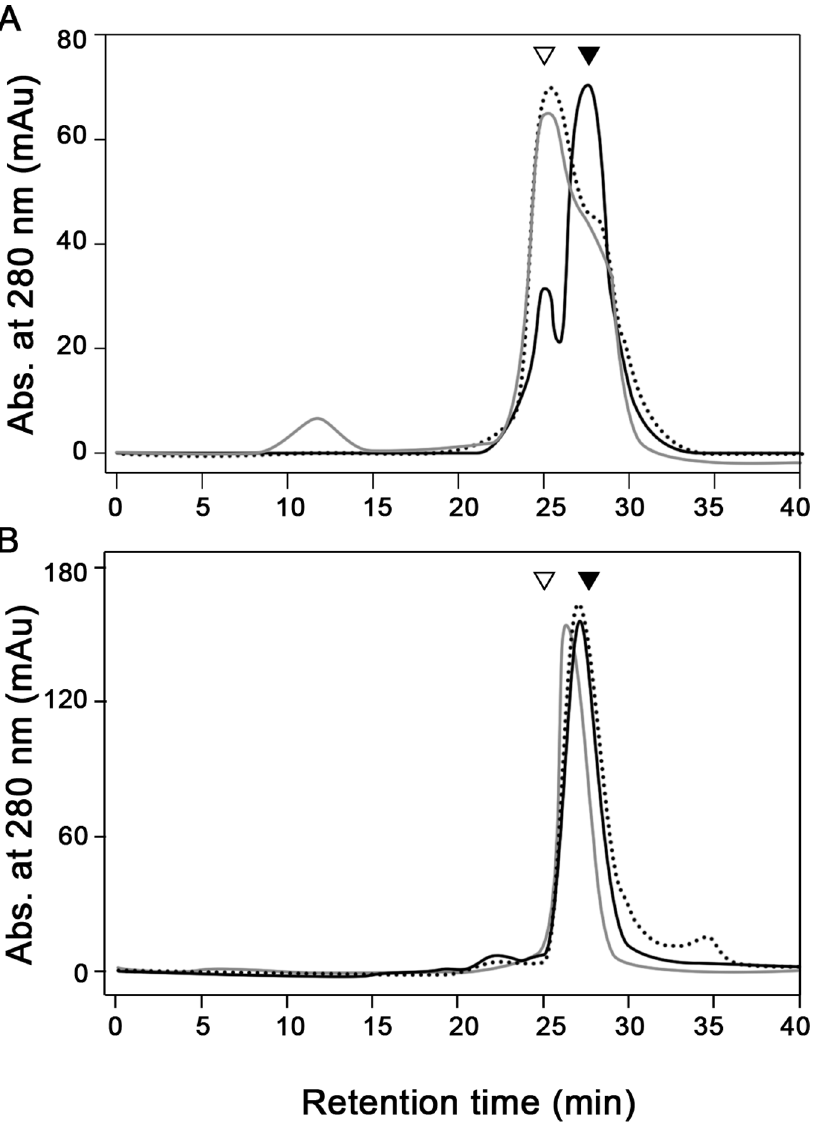
Figure 6. Determination of PaNTD oligomeric state using gel filtration chromatography. A typical elution profile is shown: (A) PaNTD and (B) EcNTD proteins (22 m M) nucleotide free (full black line), bound to ADP (dotted line) or bound to ATP (full grey line) were analyzed on a Superose 12 column as described in Matherial and Methods. Arrow heads indicate the elution positions of MW standards ( = BSA 66 kDa; . BSA 45 kDa).